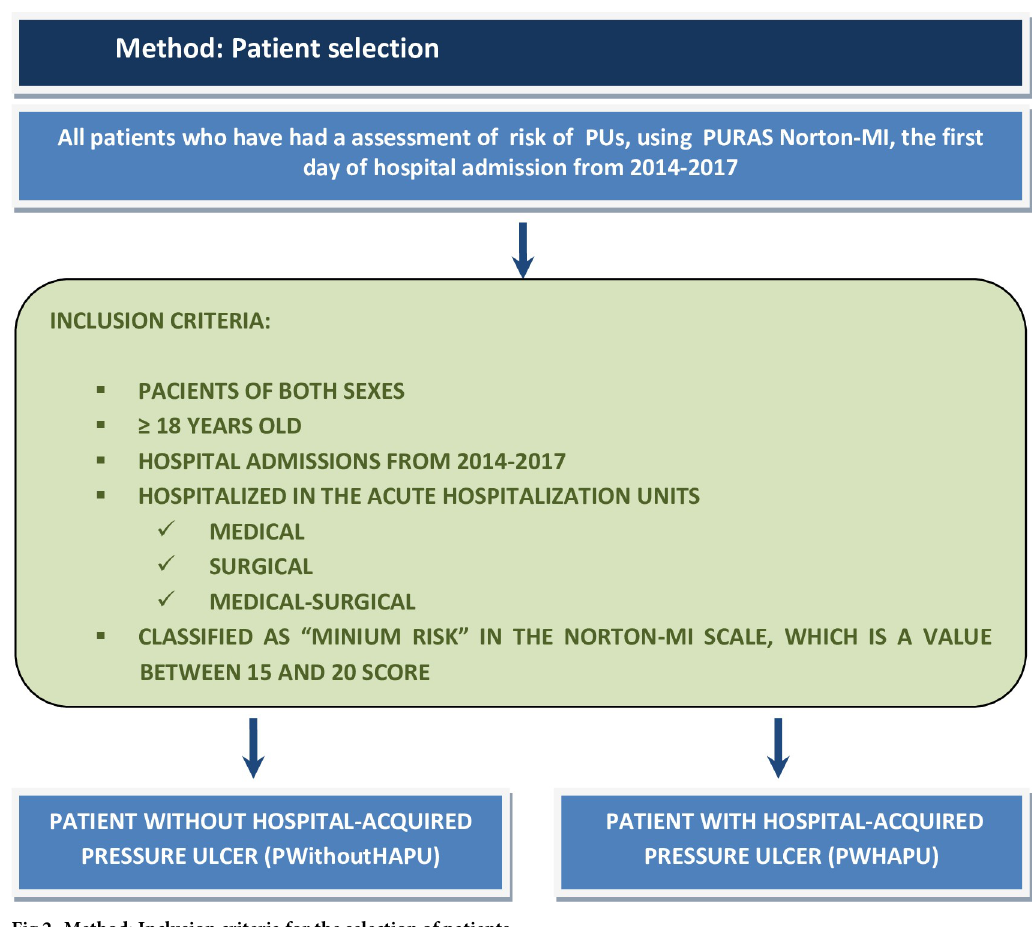
Fig 2. Method: Inclusion criteria for the selection of